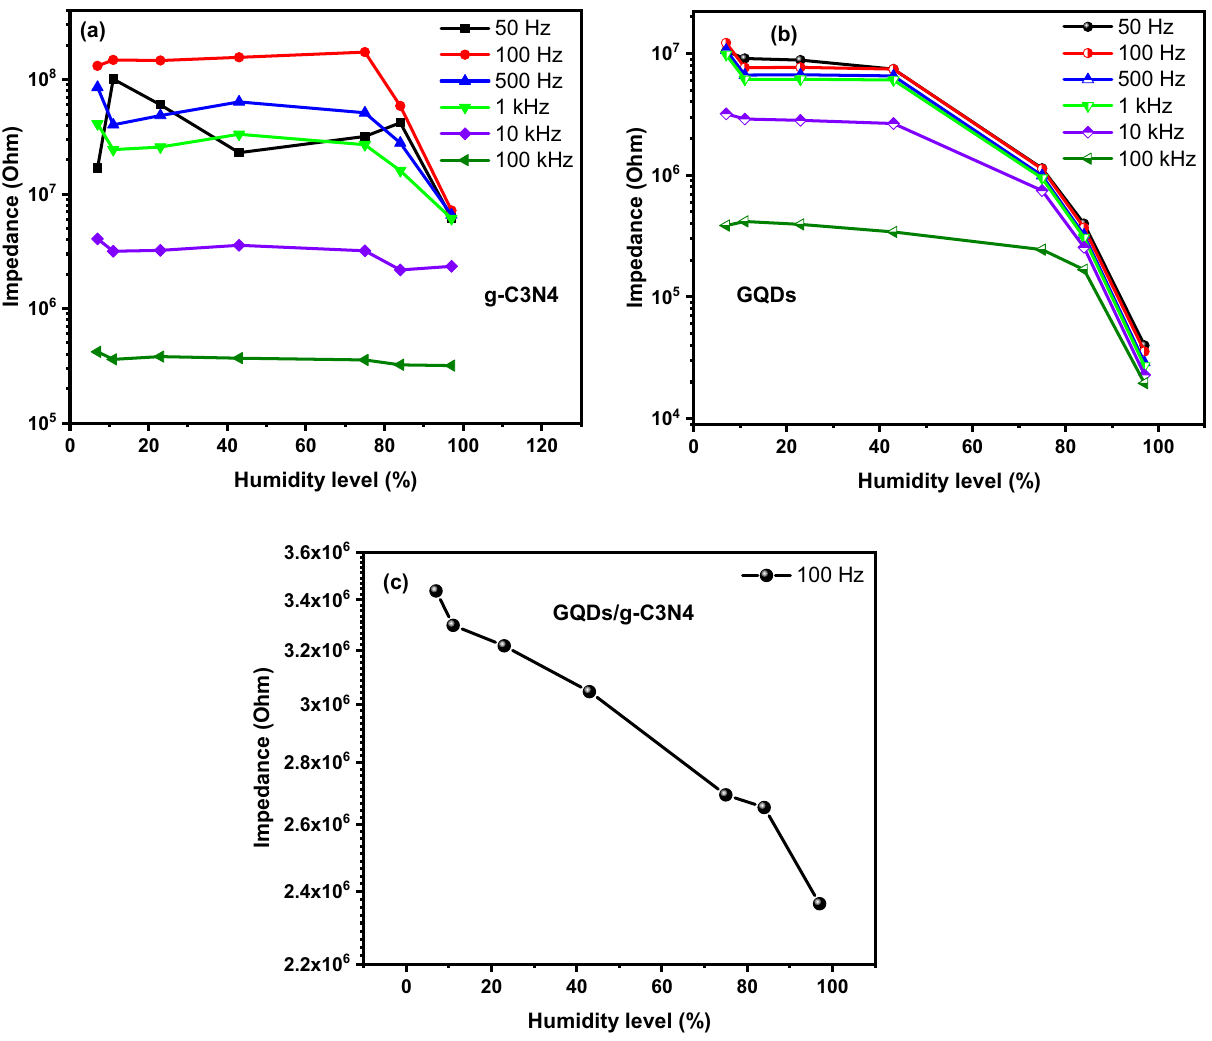
Figure 14. The humidity sensing characteristics of the ( a ) g-C3N4 at different frequencies, ( b ) GQDs at different frequencies, and ( c ) GQDs/g-C3N4 at 100 Hz.